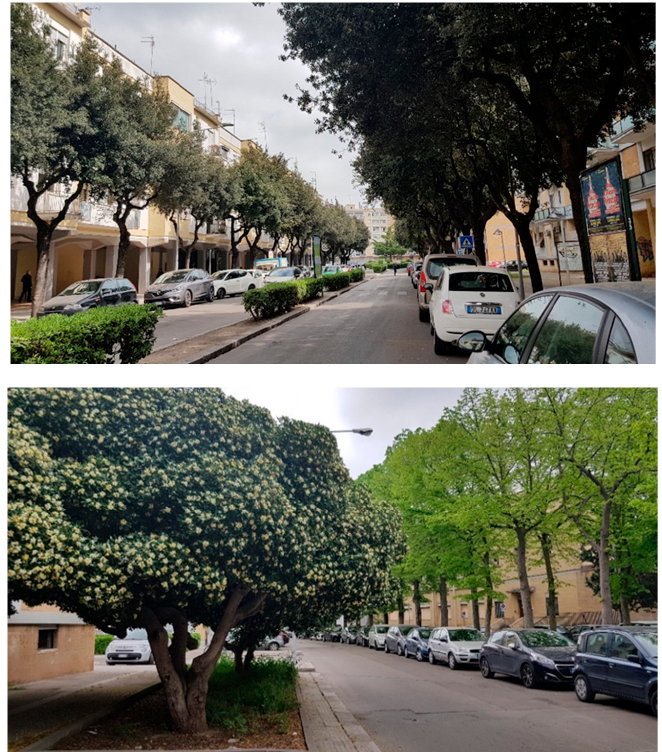
Figure 5. Top: Quercus ilex L. subsp. ilex in street canyon ”a”. Bottom: Pittosporum tobira (Thunb.) W.T. Aiton and Tilia sp. in street canyon “b”.